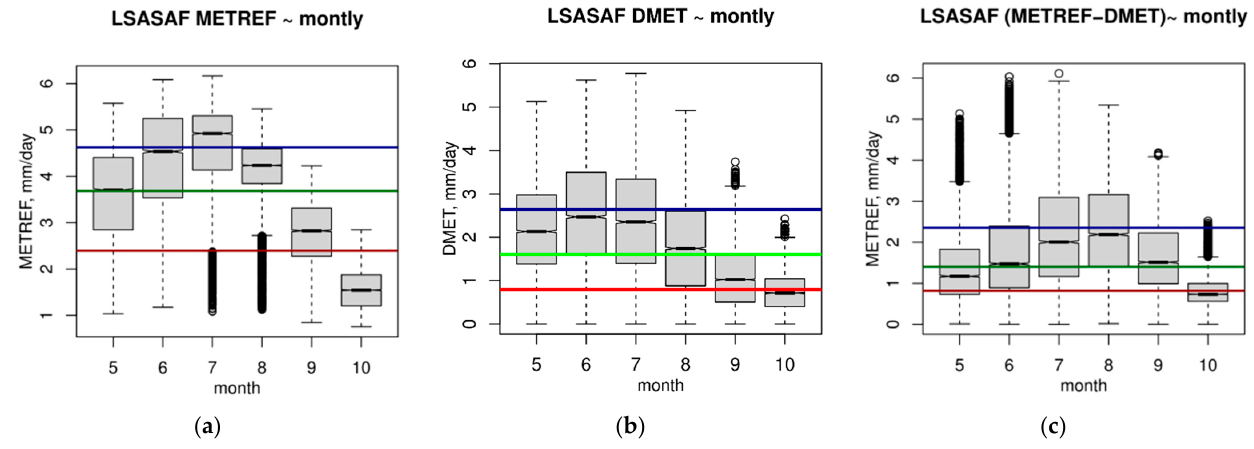
Figure 2. Boxplots of monthly mean values (2011–2020) during the growing season (May–October) for the region of Bulgaria: ( a ) LSASAF METREF; ( b ) LSASAF DMET; ( c ) difference between ME- TREF and DMET. The boxes represent the interquartile range (25th to 75th percentile, red and blue lines, respectively), whiskers cover 99.3% of the data, and the middle (green) line represents the mean values.